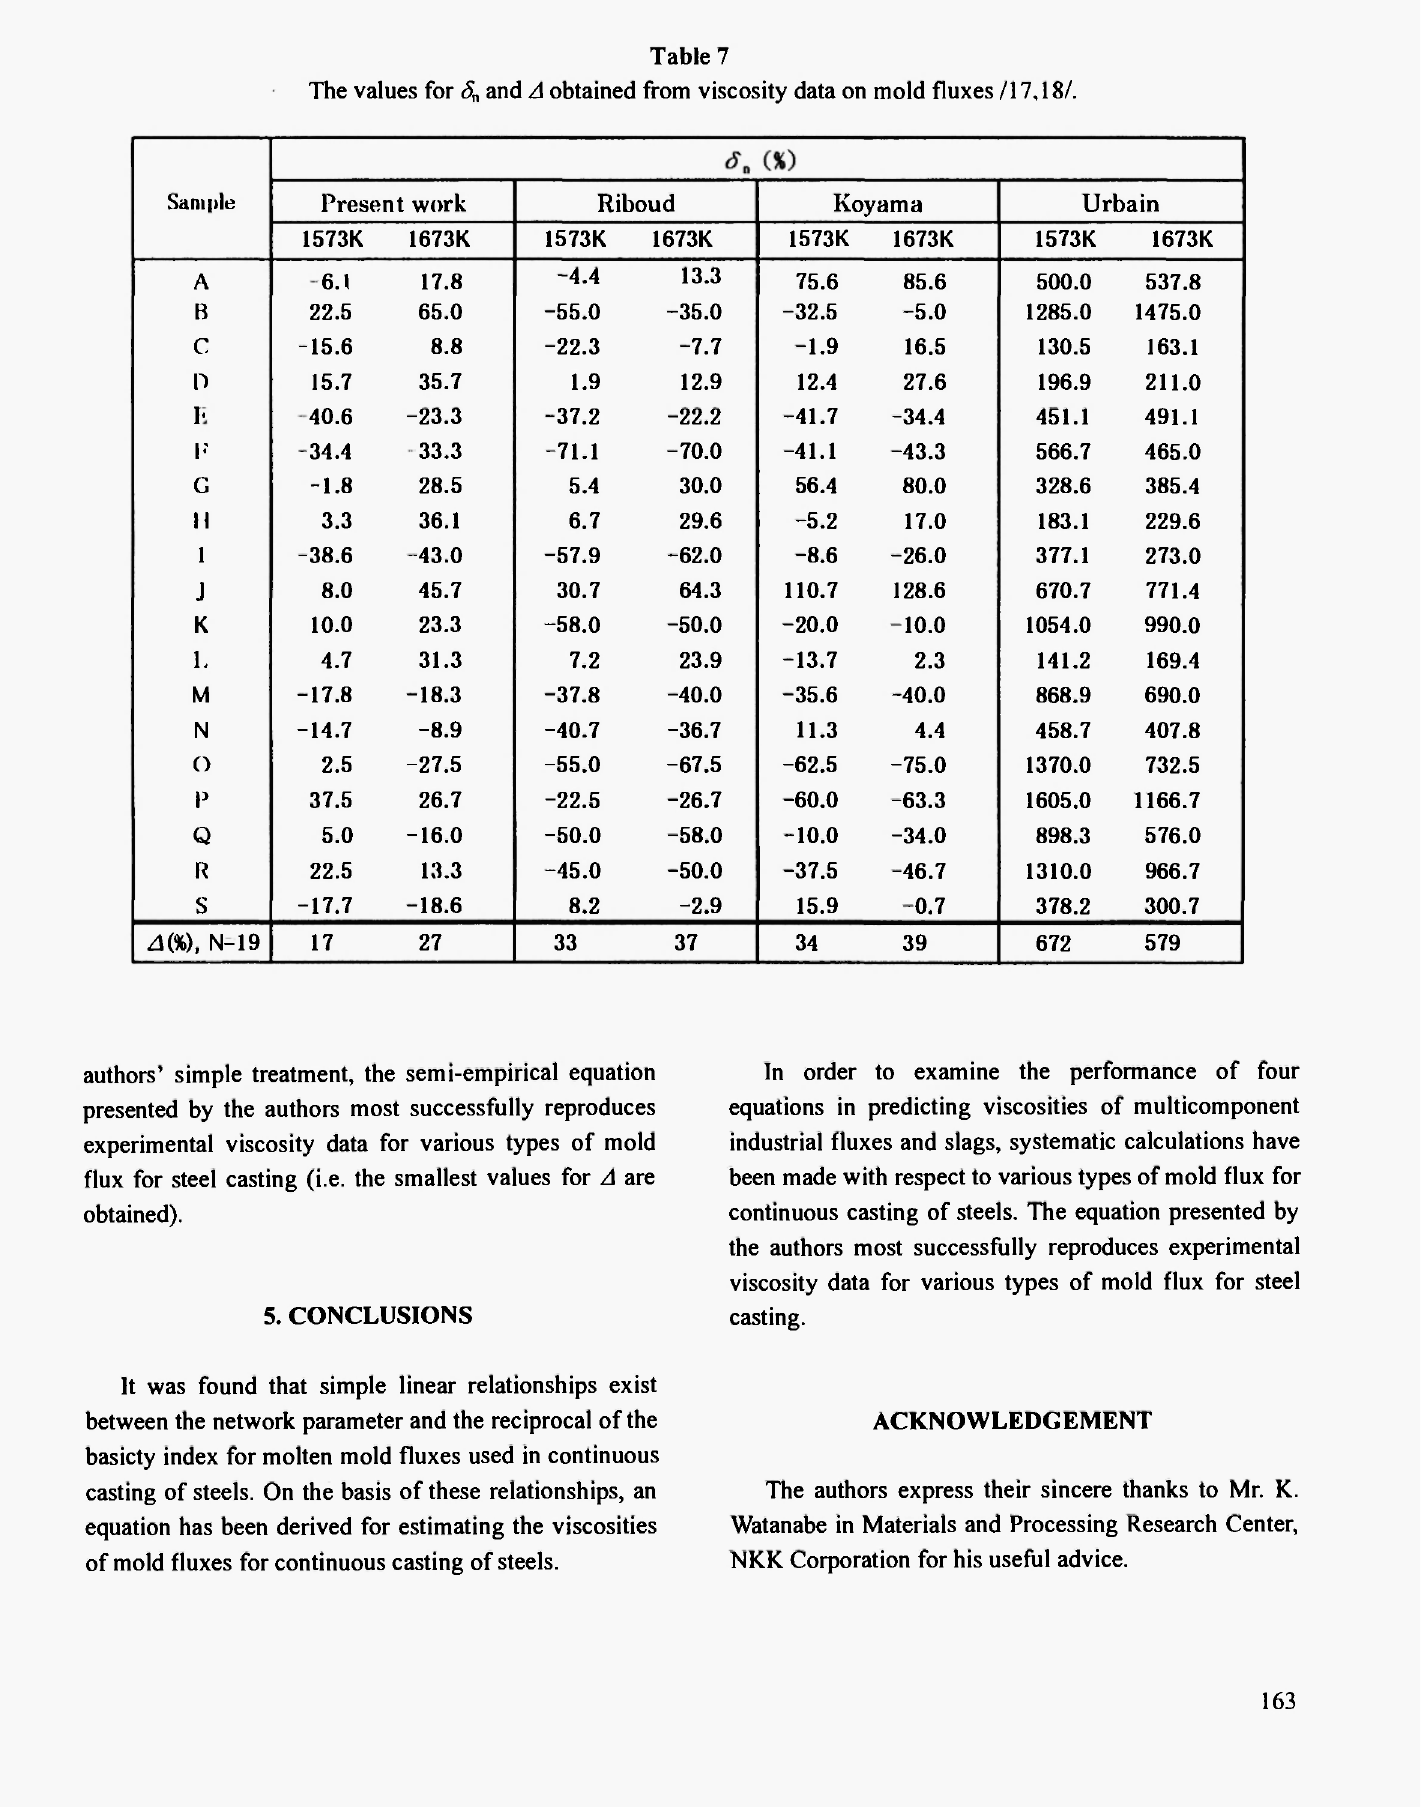
The values for δ„ and A obtained from viscosity data on mold fluxes